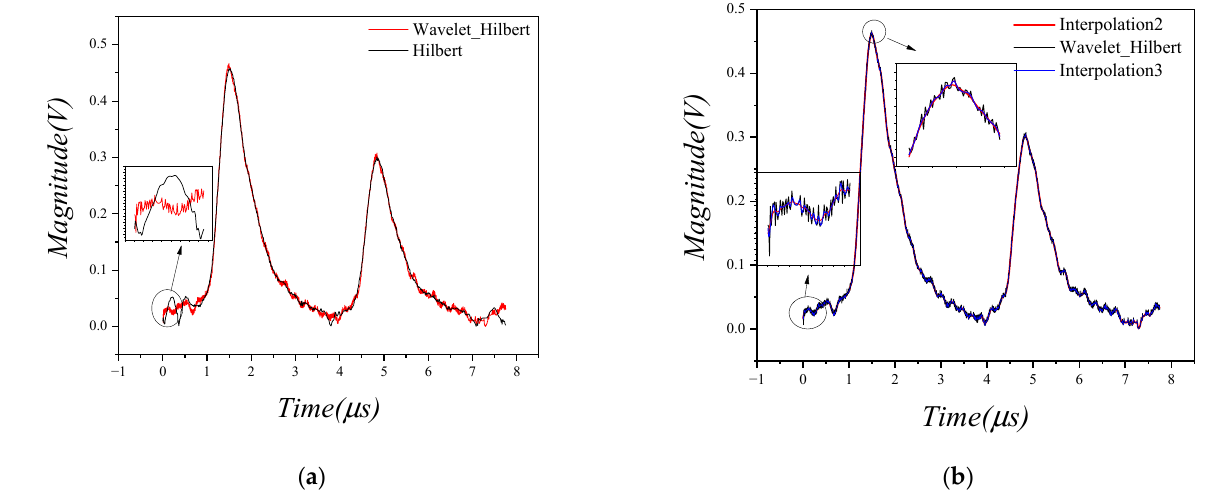
Figure 12. IMF results of a representative ultrasonic echo signal acquired with a 304SS sample from low to high frequencies after wavelet filtering.